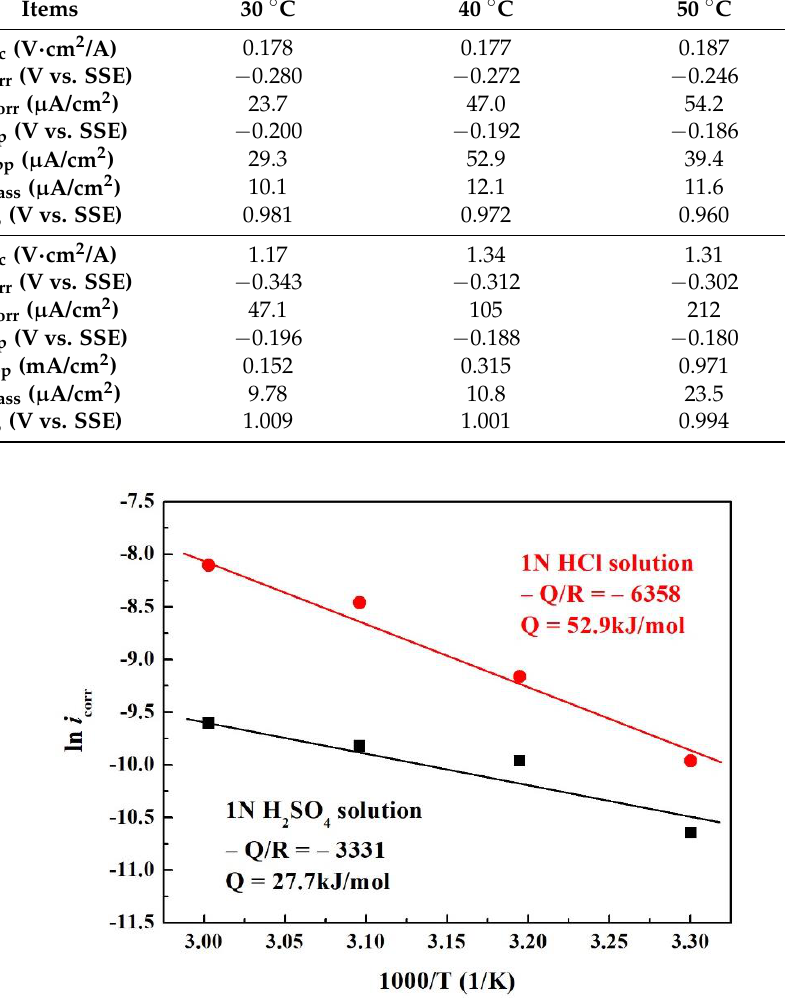
Figure 6. Arrhenius plot displaying the relationship between corrosion current density and testing temperature of the Cr 27 Fe 24 Co 18 Ni 26 Nb 5 alloy tested in deaerated 1 N H 2 SO 4 and deaerated 1 N HCl solutions.